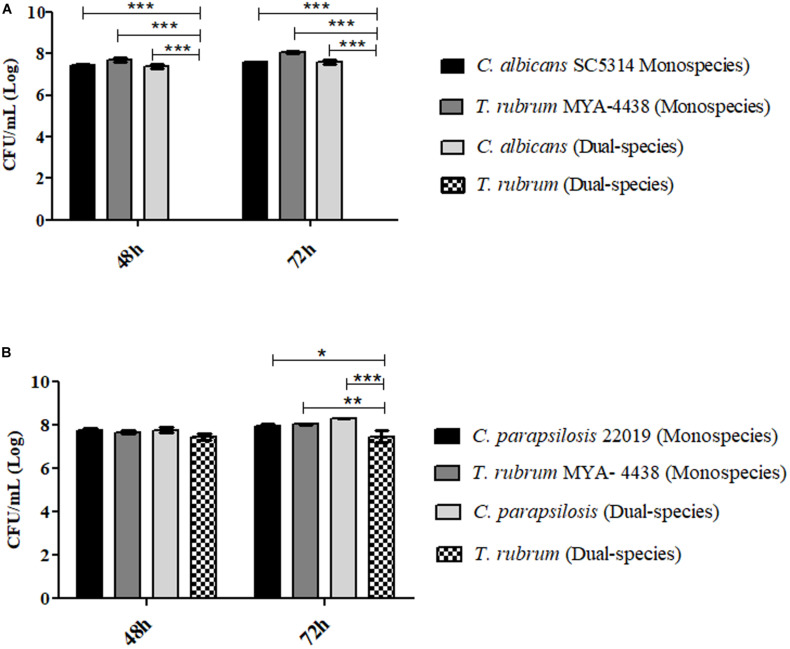
Log of colony forming units per milliliter [CFU/mL] (Log) isolated from mono- and dual-species C. albicans SC 5314 and T. rubrum ATCC MYA 4438 biofilms (1:1) (A) and isolated from mono and dual-species biofilms of C. parapsilosis ATCC 22019 and T. rubrum ATCC MYA 4438 (B) formed under the same conditions after 48 h and 72 h of incubation. Statistical significance: *p < 0.05, **p < 0.01, and ***p < 0.0001.